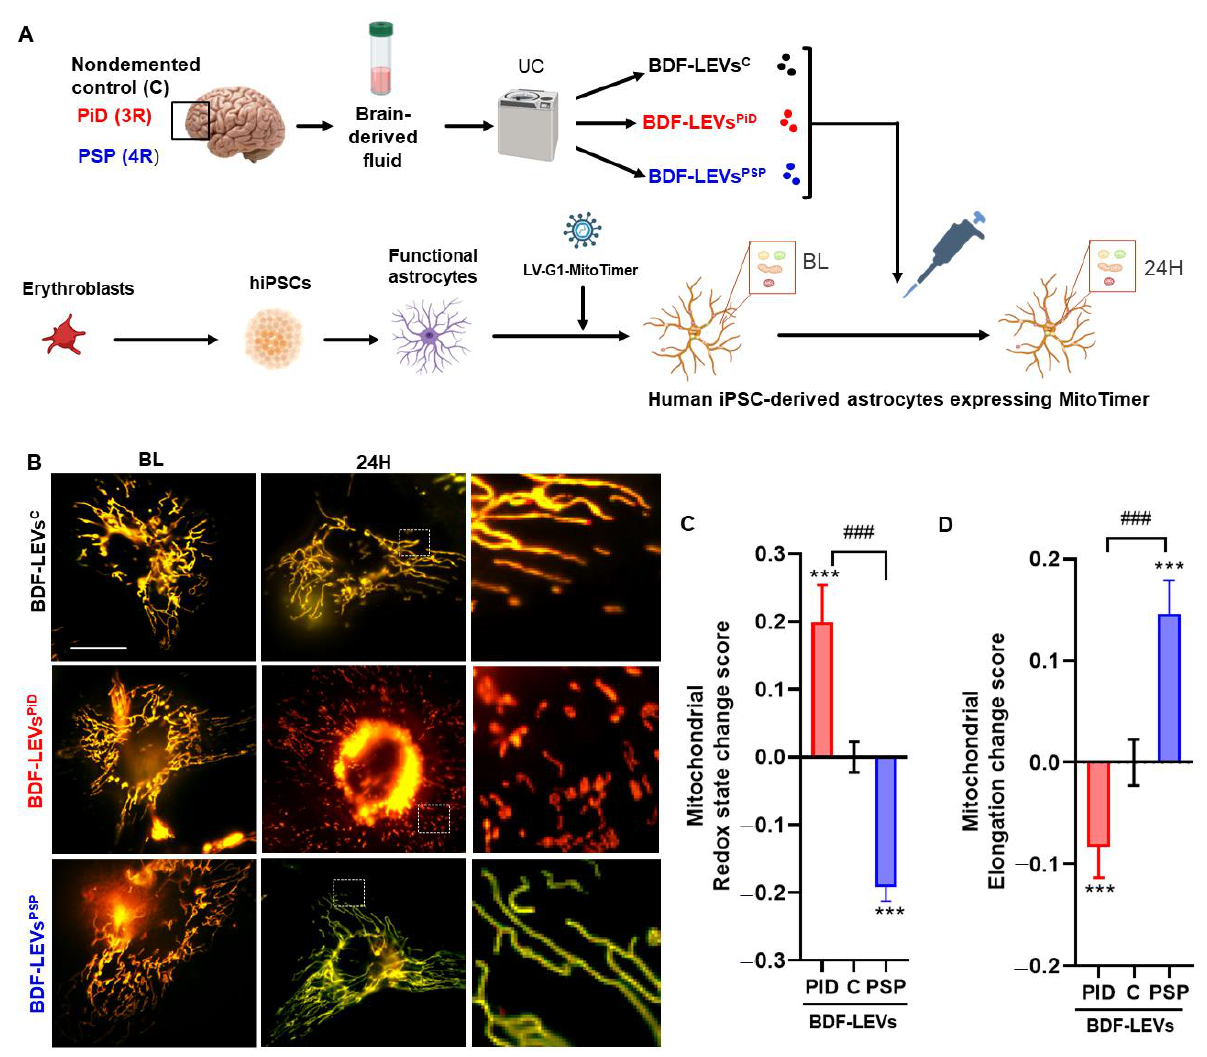
Figure 5. LEVs from 3R and 4R tauopathies induce differential mitochondrial dysfunction in iPSC- derived astrocytes. ( A ) Schematic representation of the protocols used to isolate BDF-EVs from patients diagnosed with PiD or PSP and non-demented control subjects ( C ) and to treat iPSC- derived astrocytes. ( B ) Micrographs of the mitochondrial system in human iPSC-derived astrocytes expressing the biosensor MitoTimer before (BL) and after (6 h and 24 h) treatment with BDF-LEVs PiD and BDF-LEVs PSP . ( C ) Histogram showing mitochondrial redox state changes in iPSC-derived astrocytes 24 h after BDF-LEVs treatment. ( D ) Histogram showing mitochondrial elongation in iPSC-derived astrocytes 24 h after BDF-LEVs treatment. N = cultures/cells/mitochondria; ND- LEVs CFP : 3/21/801, ND-LEVs 1N3R : 3/15/958, ND-LEVs 1N4R : 4/14/789, BFD-LEVs C : 3/19/3883, BFD-LEVs PiD : 3/21/749, BFD-LEVs PSP : 4/17/2555. Two-way matched ANOVA followed by